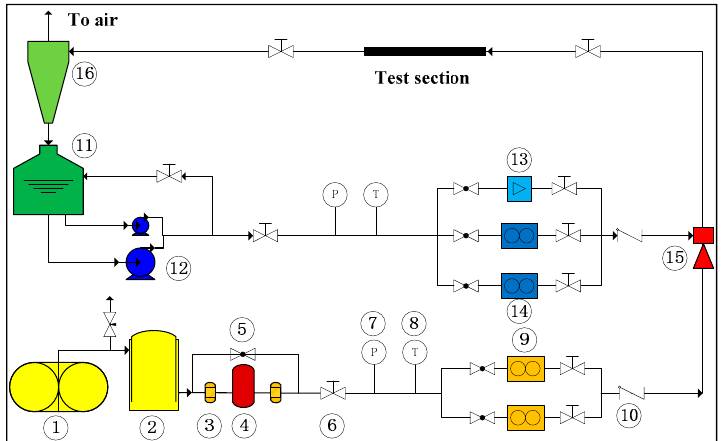
Figure 3. Flow diagram of flow loop: (1) Win-screw compressor; (2) air storage reservoir; (3) filter; (4) freezing dryer; (5) globe valve; (6) regulating valve; (7) pressure meter; (8) temperature gauge; (9) air Coriolis mass flow meter; (10) one-way valve; (11) water tank; (12) centrifugal pump; (13) electromagnetic flow meter; (14) water mass flow meter; (15) gas–liquid mixer; (16) gas–liquid separator. Table 2. Measurement devices employed in this article.